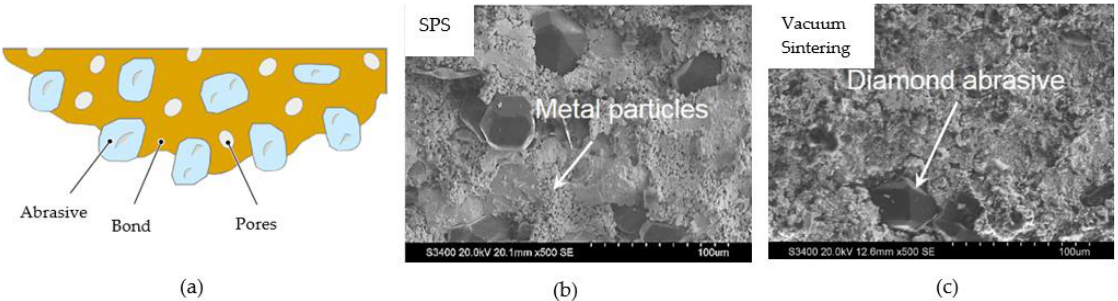
Figure 4. ( a ) Elements of the abrasive product in dicing blade; SEM micrograph of dicing blade fabricated from ( b ) SPS; ( c ) vacuum sintering [13,16].